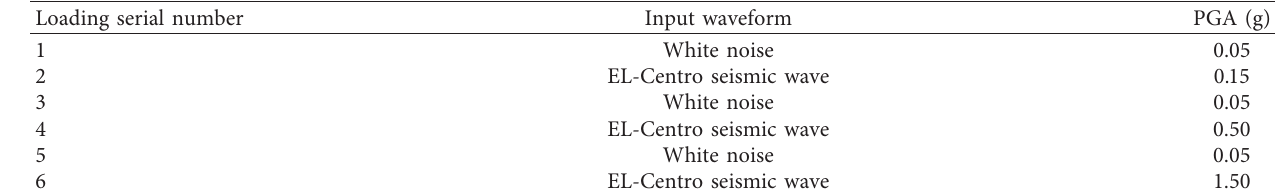
Table 5: Test loading